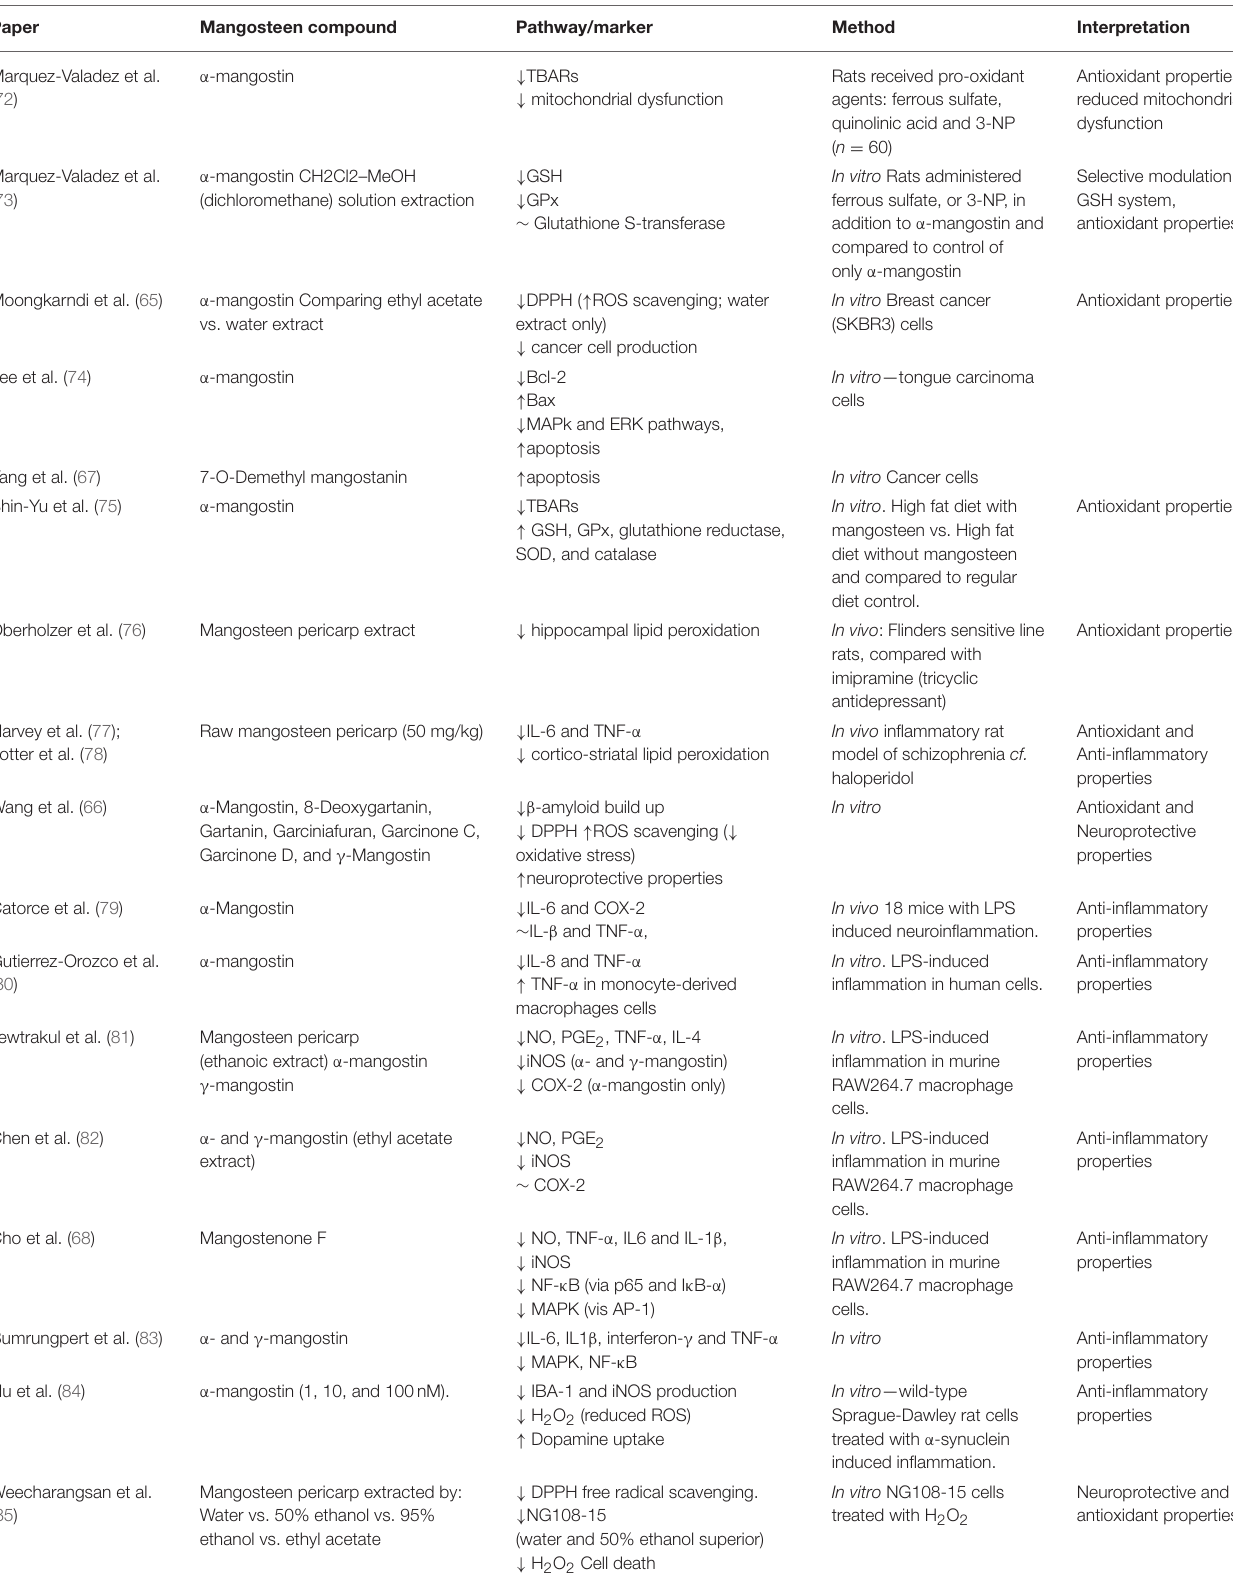
TABLE 1 | Summary of neurobiological activity of Garcinia mangostana Linn .